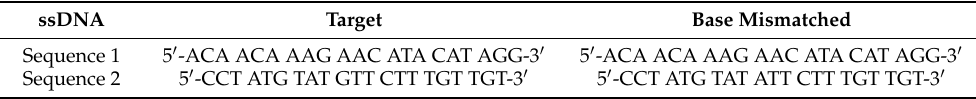
Table 1. DNA sequences of target and base mismatched samples.